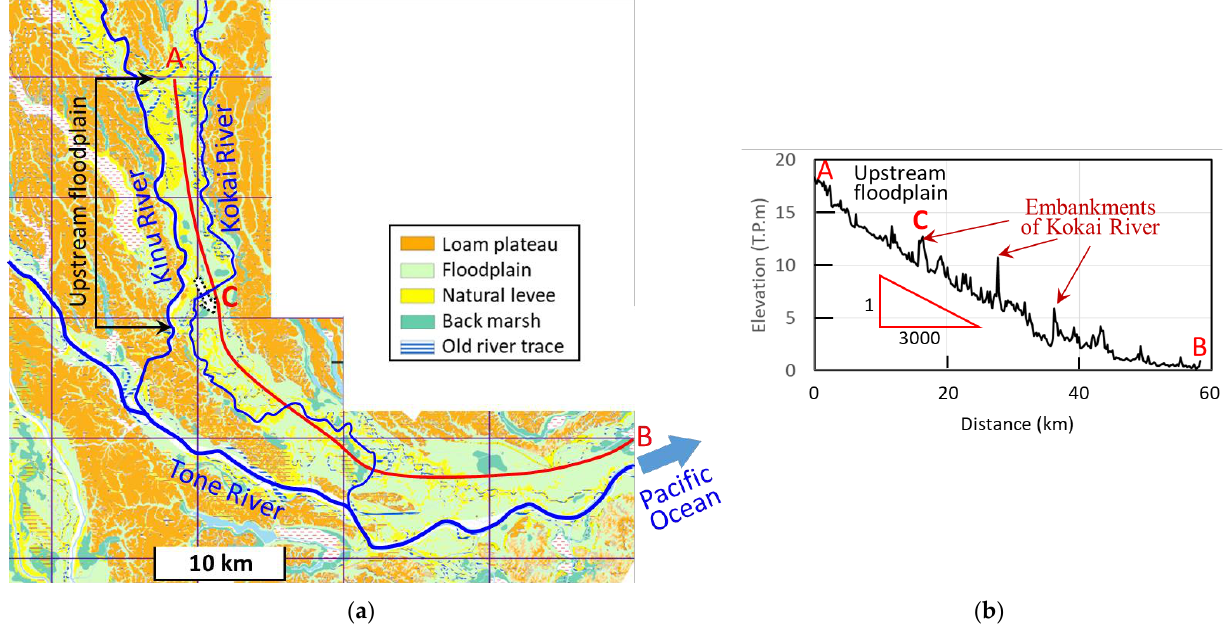
Figure 7. Study site (Old Kinu River Floodplain); ( a ) flood control landform classification map and ( b ) topographical cross section of survey line indicated by red line in ( a ) (T.P.: Tokyo Peil).